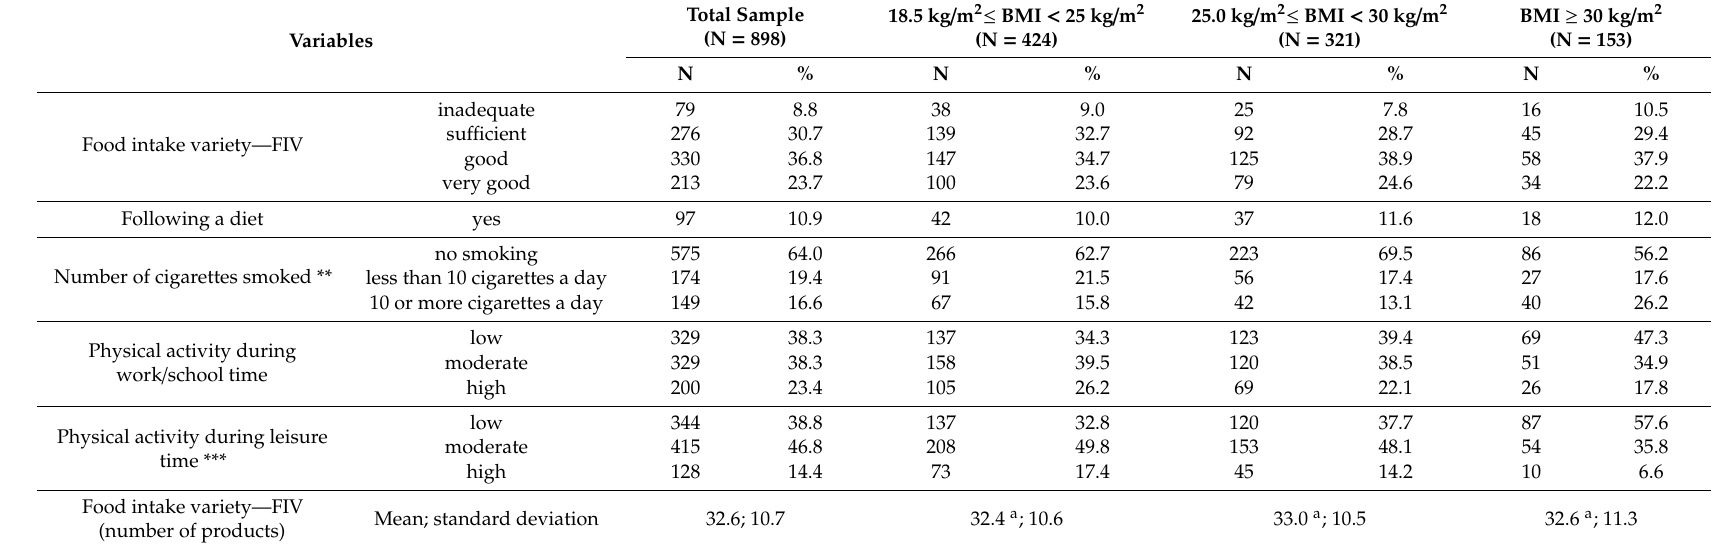
Table 3. Food intake variety and other lifestyle characteristics of the study